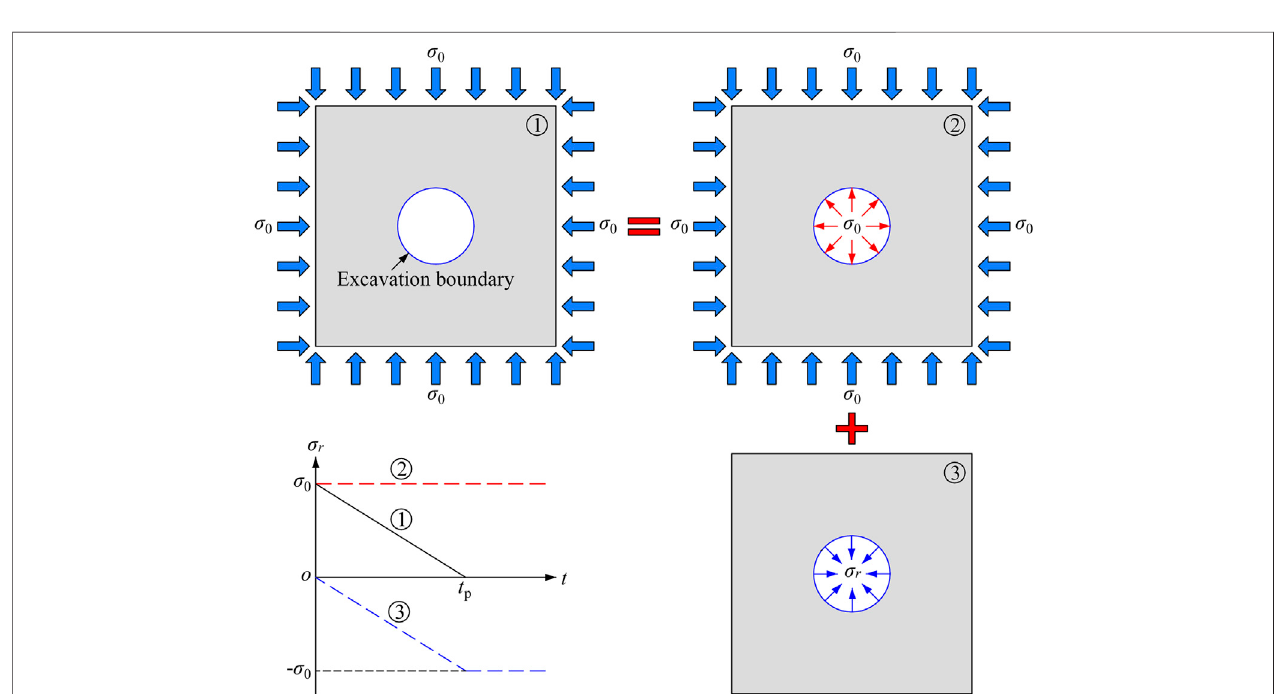
Frontiers in Earth Science |